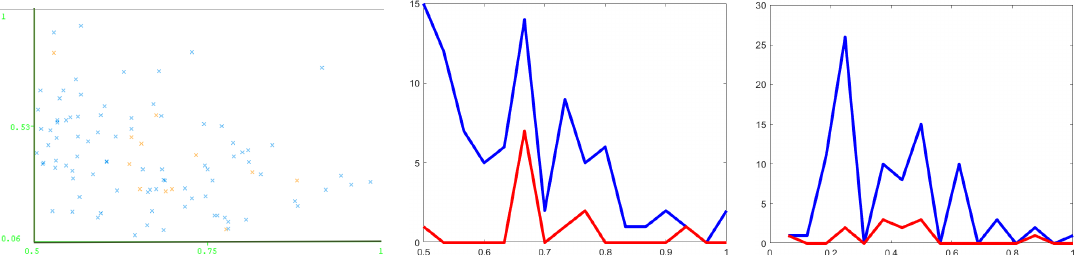
Figure A4. Scatter and Histogram of Fertility Dataset.